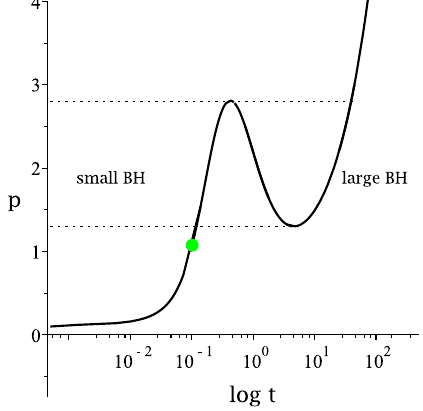
Figure 11 . Isolated critical point with double reentrant phase transition: shown here for q = 0 and (cid:11) = (cid:0) 5 with (cid:15) = (cid:0) 1, the isolated critical point occurs for h = h (cid:14) = (cid:0) 1 ;(cid:15) = (cid:0) 1 (cid:25) 0 : 882797 an isolated critical point (green dot) occurs along with a double reentrant phase transition. The solid black line, which denotes a a coexistence curve for a (cid:12)rst order phase transition, separates small and large black holes. For pressures between the two dotted lines, a small/large/small/large black hole phase transition